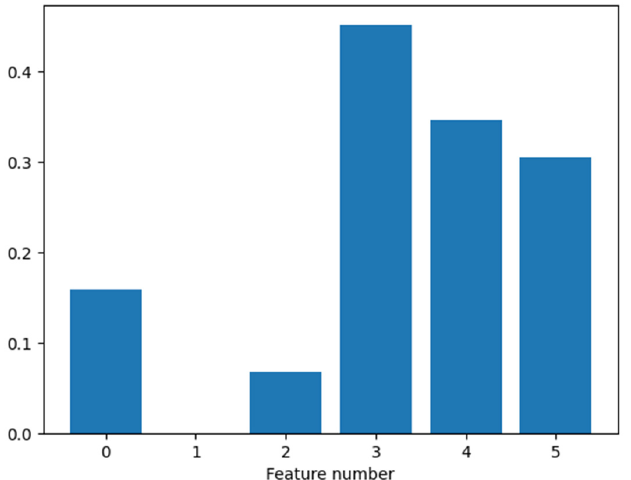
Figure 8. Permutation features important values for optimised LR model.